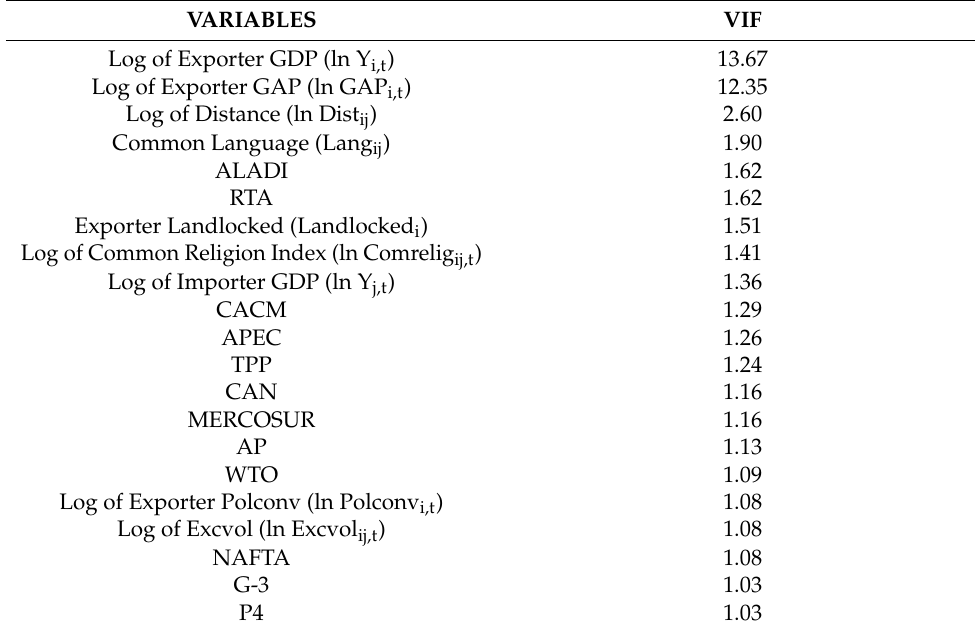
Table 3. Variance Inflation Factor